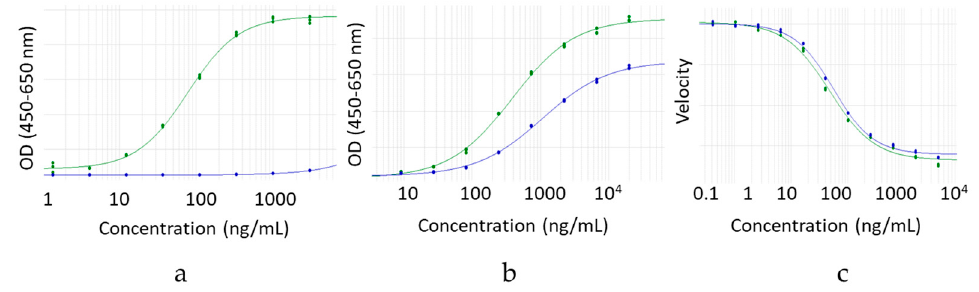
Figure 5. Binding of hinge deleted IgG4 (blue dilution curves) and its corresponding full-length control mAb (green dilution curves) to ( a ) Fc γ RI by ELISA, ( b ) FcRn by ELISA. ( c ) Enzymatic inhibition of the MMP9 target antigen.